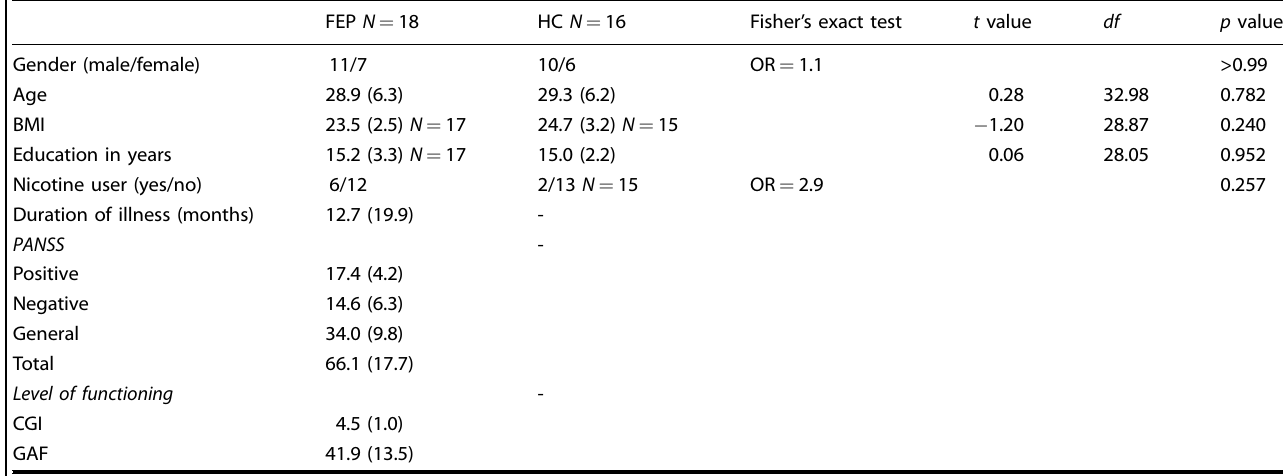
Table 1. Demographic and clinical data, mean (standard deviation).